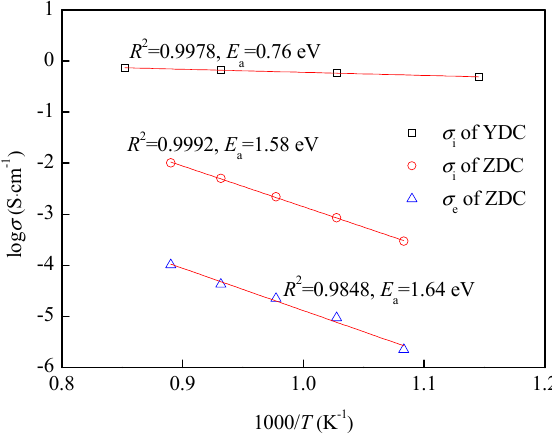
Figure 5. Ionic conductivity of YDC and ionic, electronic conductivity of ZDC.